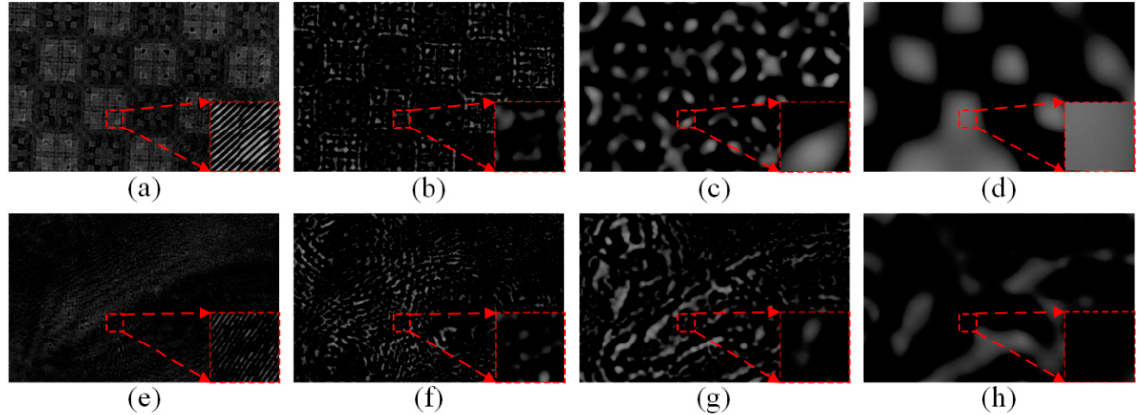
Figure 5. Reconstruction results with different IMF components selected. ( a ) The first IMF component C 1 of Figure 4b is selected to reconstruct the image. ( b ) The third IMF component C 3 of Figure 4b is selected to reconstruct the image. ( c ) The fifth IMF component C 5 of Figure 4b is selected to reconstruct the image. ( d ) The seventh IMF component C 7 of Figure 4b is selected to reconstruct the image. ( e ) The first IMF component C 1 of Figure 4d is selected to reconstruct the image. ( f ) The third IMF component C 3 of Figure 4d is selected to reconstruct the image. ( g ) The fourth IMF component C 4 of Figure 4d is selected to reconstruct the image. ( h ) The sixth IMF component C 6 of Figure 4d is selected to reconstruct the image.